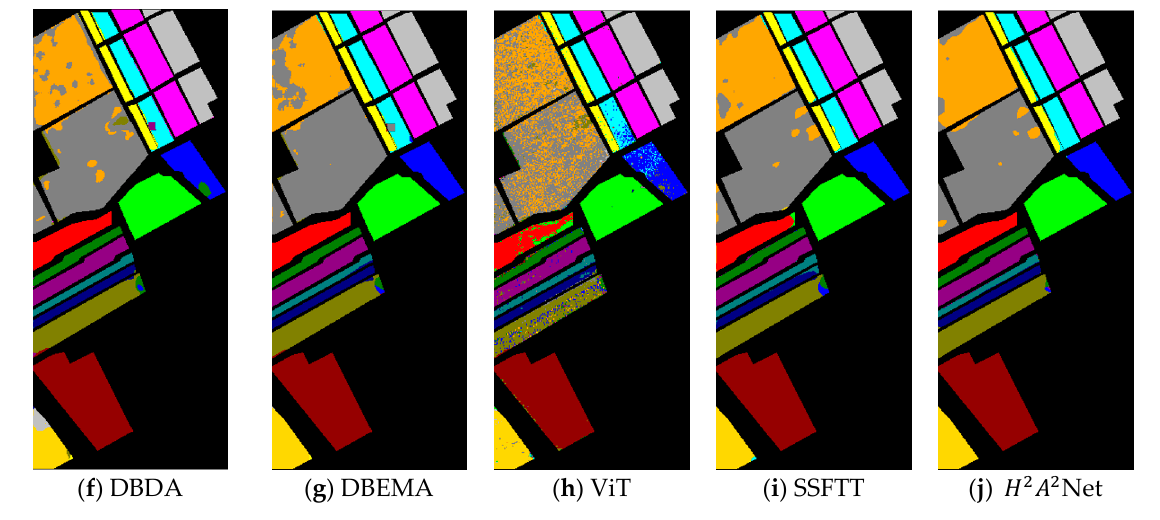
Figure 9. Classification maps achieved by different methods for the SV dataset. ( a ) False color image.